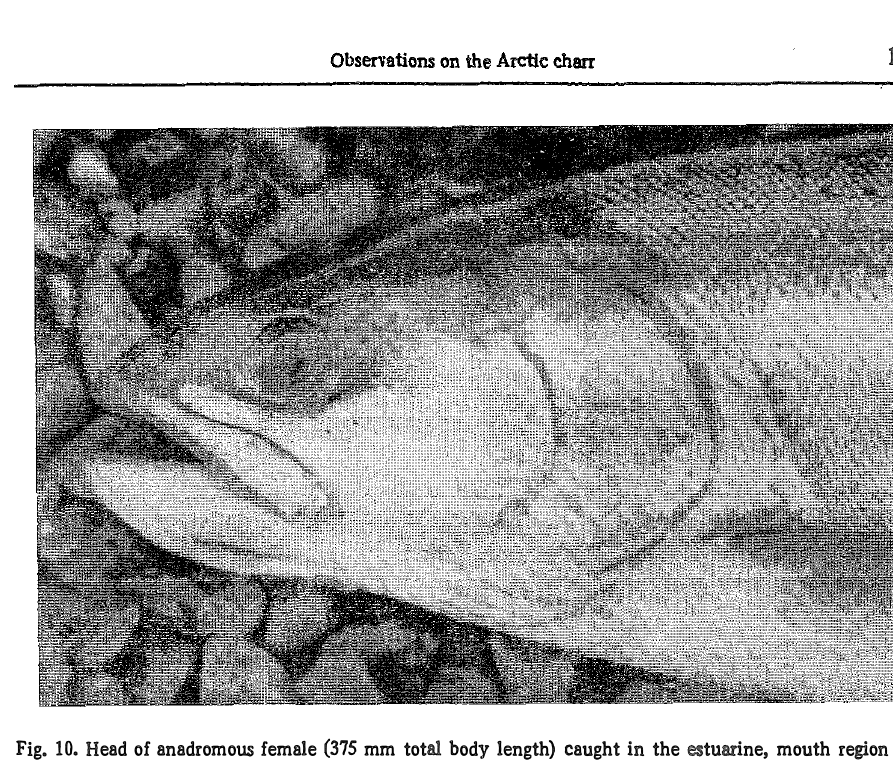
Fig. 1 O. Head of anadromous female (375 mm totlil. body length) caught in the estumine, mouth region of